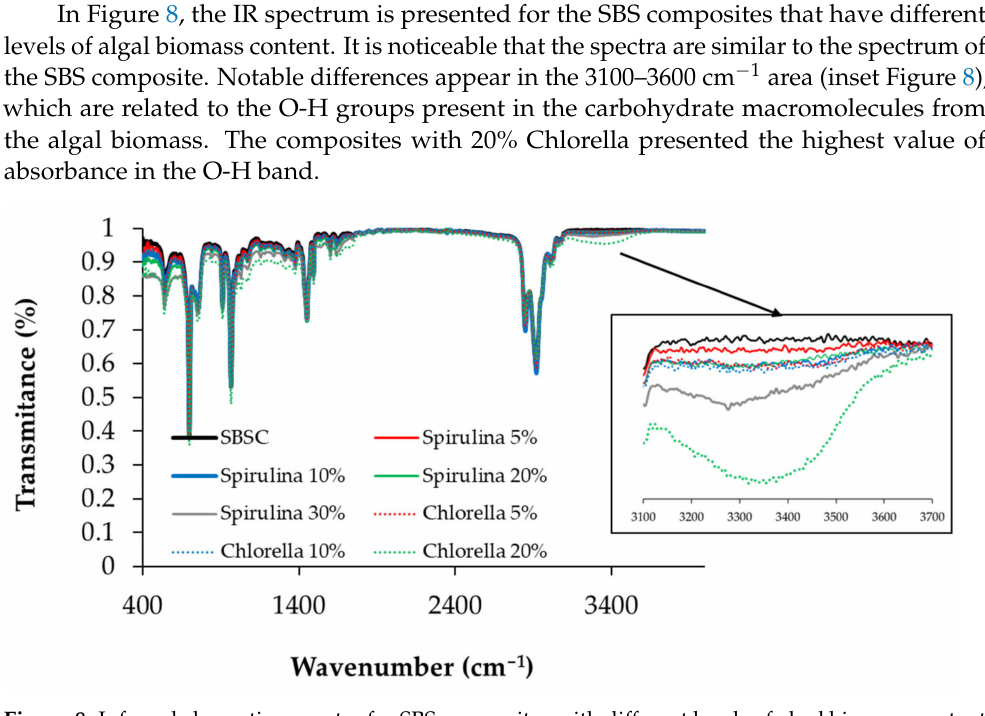
Figure 8. Infrared absorption spectra for SBS composites with different levels of algal biomass content (% w / w